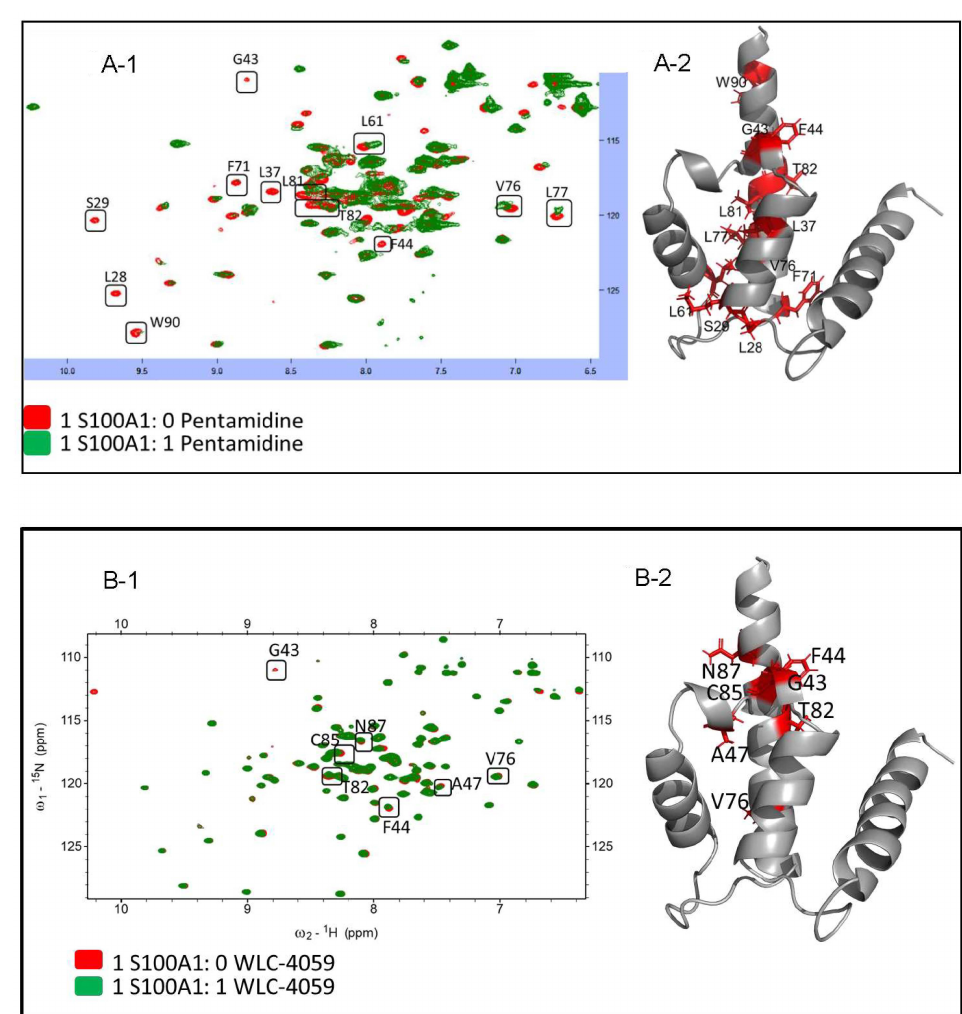
Figure 2. The HSQC titration of S100A1 with pentamidine/pentamidine derivative (WLC-4059). ( A-1 ): HSQC results of S100A1 with pentamidine with the perturbed residues in boxes and labeled in black. The perturbed residues are shown in the 3D crystal structure of S100A1 in stick form and colored in red shown in ( A-2 ). ( B-1 ): HSQC results of S100A1 with the pentamidine derivative (WLC-4059) with the perturbed residues in boxes and labeled in black. The perturbed residues are shown in the 3D crystal structure of the S100A1 in stick form and colored in red in ( B-2 ). The overlapping of the 1 H- 15 N HSQC spectra of free mS100A1 and the complex of mS100A1 with pentamidine and WLC-4059 was determined to identify mS100A1